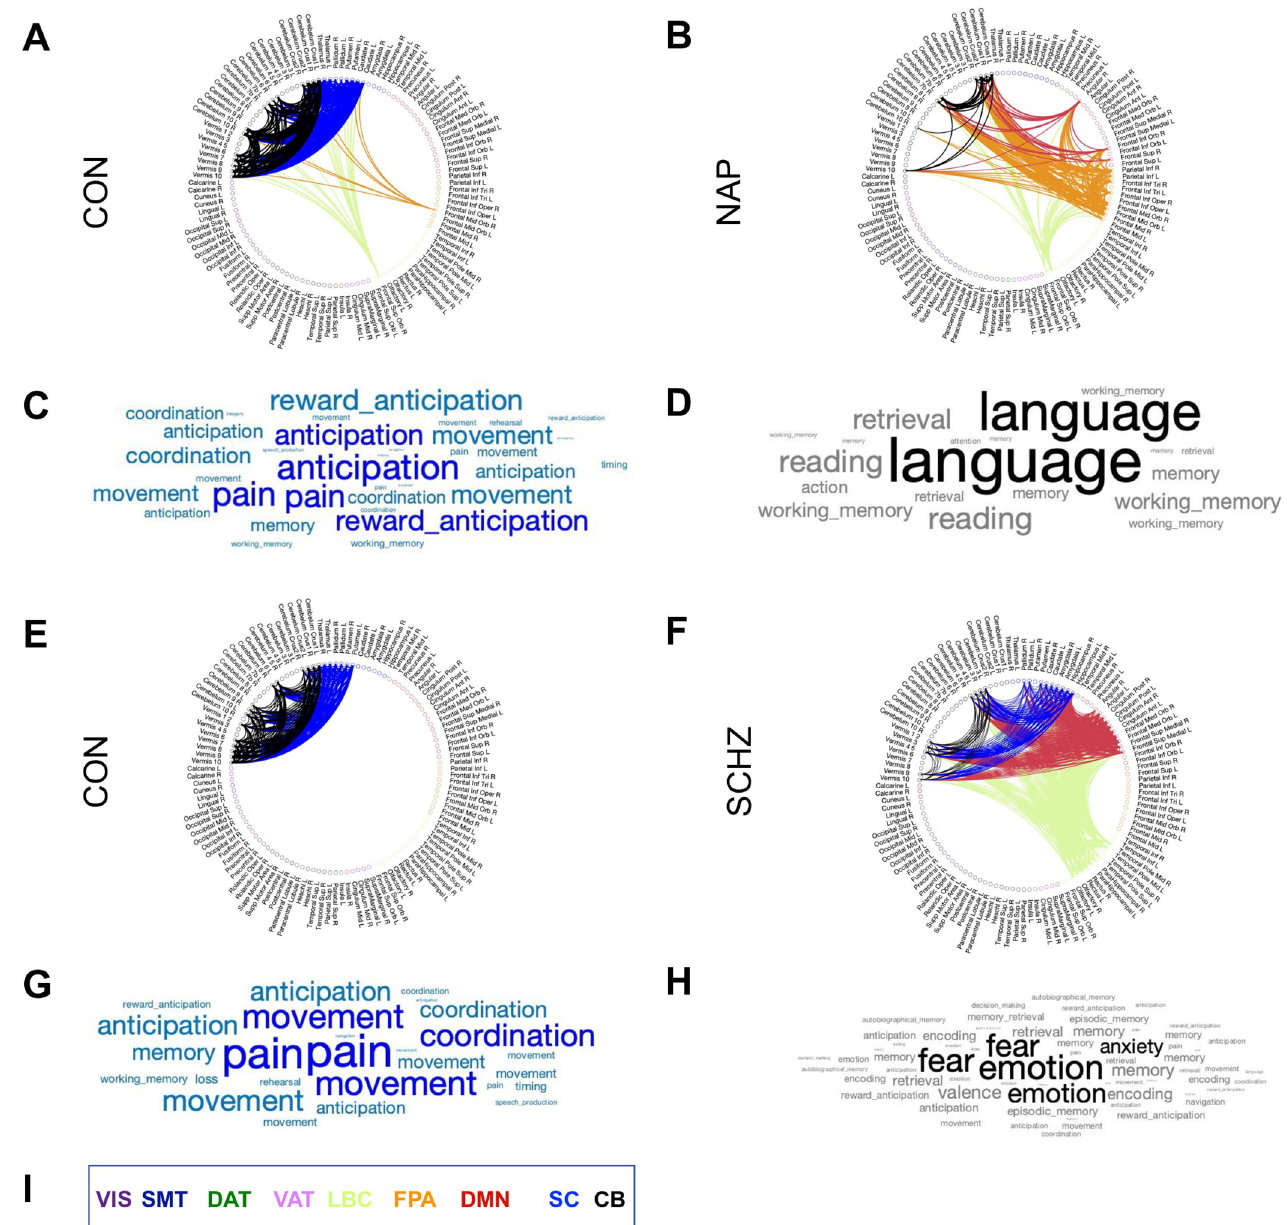
Fig 5. Connectograms and word clouds for Mode ψ 4 in RUN2. A) Group-level FC in Mode ψ 4 for HCPEP controls. B) Group-level FC in Mode ψ 4 for HCPEP Non-affective psychosis. C) The word cloud presents the top terms derived from Neurosynth using reverse inference for the regions in Mode ψ 4 for HCPEP controls. Word size represents the strength of the probabilistic association of the term to the regions. D) Top terms for Mode ψ 4 in HCPEP Non- affective psychosis. E) Group-wide FC in Mode ψ 4 for Cobre controls. F) Group-wide FC in Mode ψ 4 for Cobre Schizophrenia. G) Top terms for Mode ψ 4 in Cobre controls. H) Top terms for Mode ψ 4 in Cobre Schizophrenia. I) Color coded legend for the Yeo resting-state networks, subcortical and cerebellar regions. VIS, Visual; SMT, Somatomotor; DAT, Dorsal attention; VAT, Ventral attention; LBC, Limbic; FPA, Frontal parietal; DMN, Default mode network; SC, Subcortical; CB,